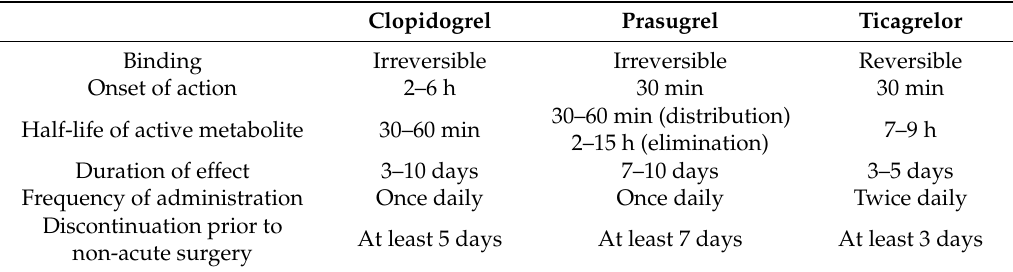
Table 1. Comparative properties involving oral P2Y12